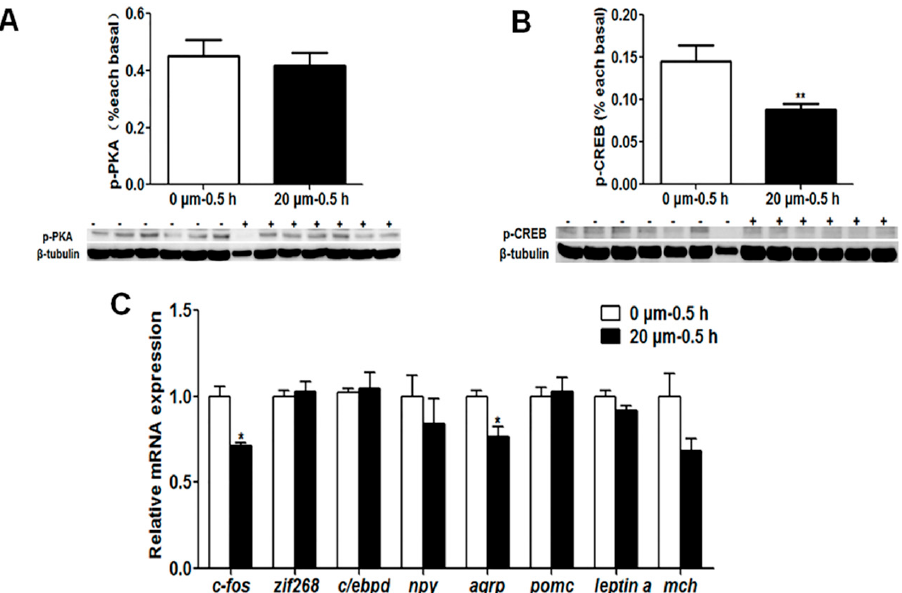
Figure 13. The phospho-protein kinase A (p-PKA) ( A ) and p-CREB levels ( B ), and learning and appetite control-relative genes expression ( C ) in mandarin fish brain cells with the treatment of inhibitor H-89 (20 μ m, 0.5 h). Data are represented as mean ± S.E.M. ( n = 6). A value followed by * differs significantly from all other values not followed by the same superscript at the same time point based on a one-way analysis of variance (ANOVA) followed by the post hoc test ( * p < 0.05, ** p < 0.01).